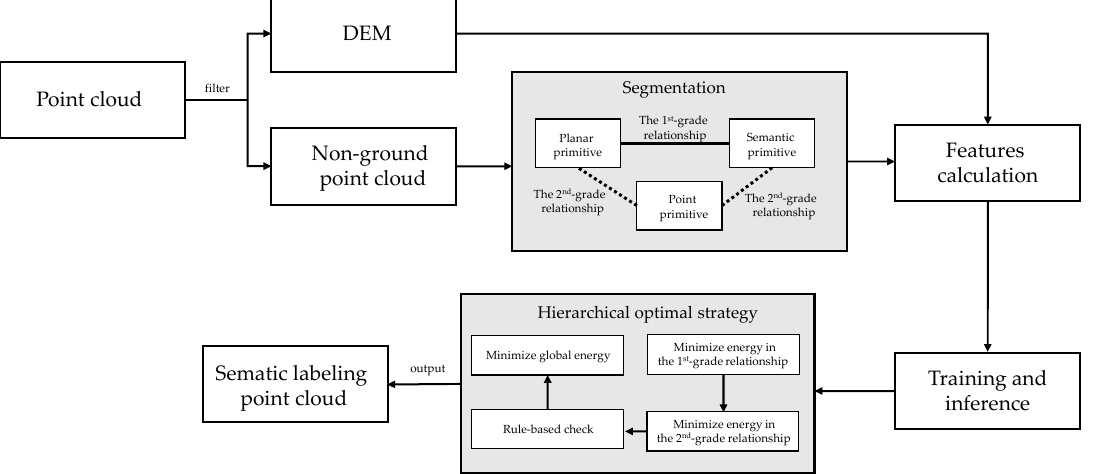
Figure 1. Framework of the proposed approach.